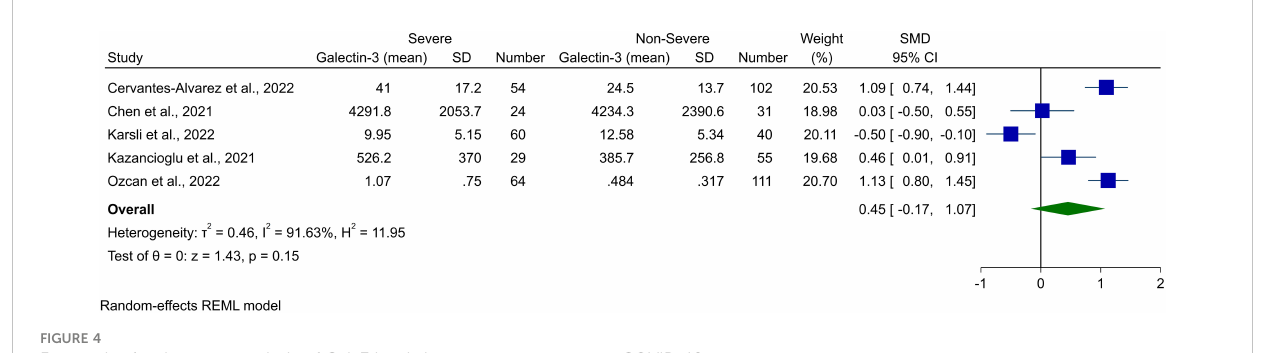
FIGURE 4 Forest plot for the meta-analysis of Gal-3 levels in severe vs. non-severe COVID-19.